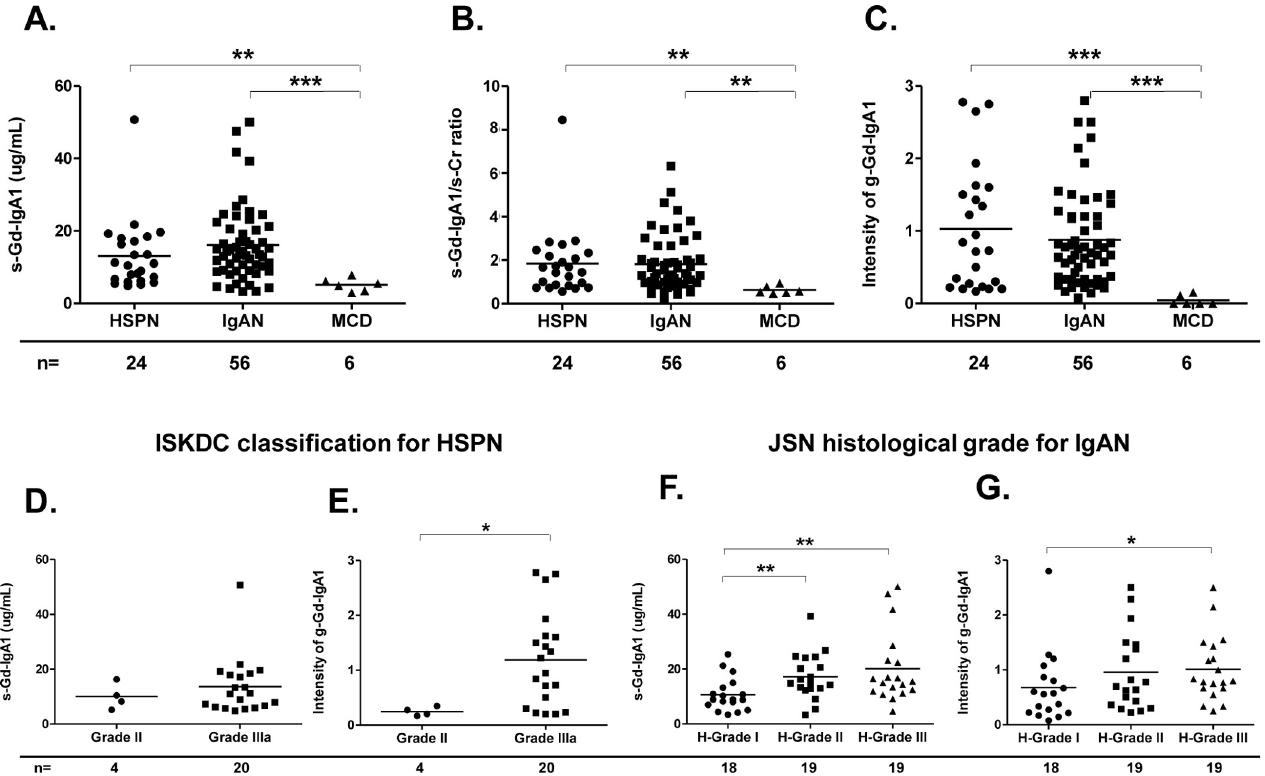
Fig 1. S-Gd-IgA1 levels determined by ELISA and g-Gd-IgA1 deposition identified by IHC staining between HSPN and IgAN. S-Gd-IgA1 levels in patients with HSPN, IgAN, or MCD (A) . Levels of s-Gd-IgA1 after correction for sCr levels. S-Gd-IgA1 values divided by sCr values for individual patients and compared among the study groups (B) . Intensity of g-Gd-IgA1 among patients with HSPN, IgAN, or MCD (C) . S-Gd-IgA1 level or m-Gd-IgA1 intensity in patients with HSPN according to ISKDC classification ( D and E ). S-Gd-IgA1 level or g-Gd-IgA1 intensity in patients with IgAN according to JSN classification ( F and G ). Horizontal solid lines represent means. Data were statistically analyzed using Kruskal-Wallis tests and Mann-Whitney U tests. � P < 0.05, �� P < 0.01, and ��� P < 0.001.